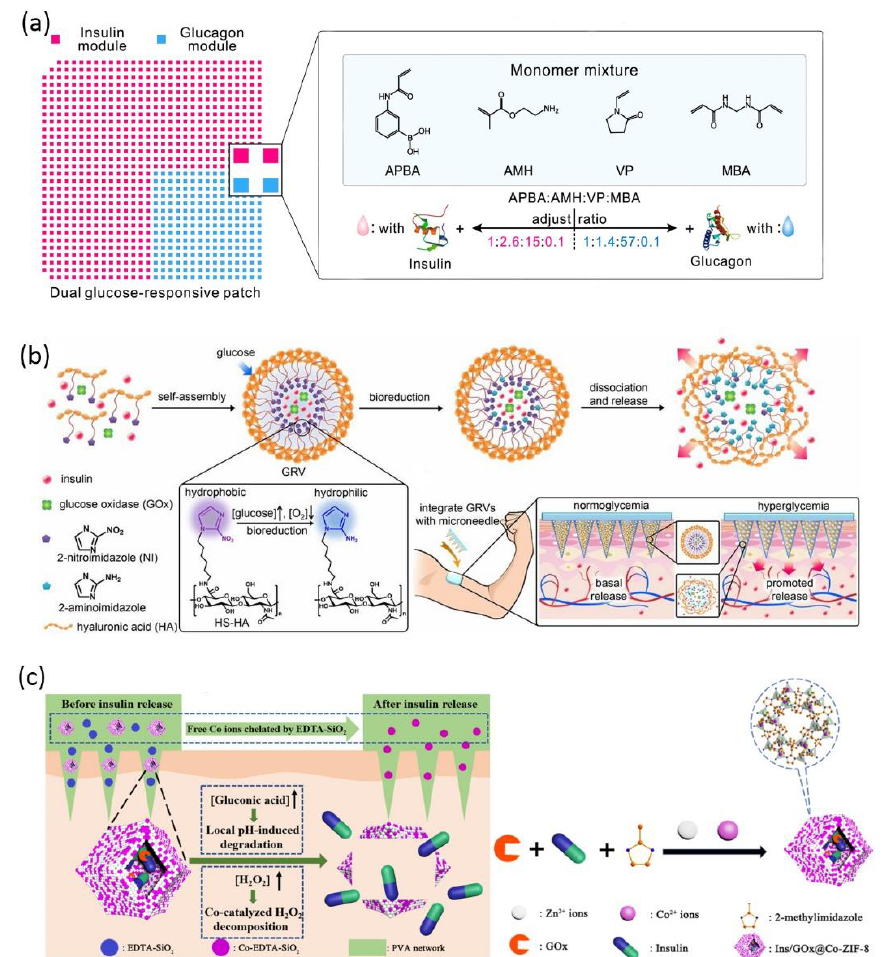
Figure 4. Schematic of glucose-responsive insulin delivery microneedles: ( a ) A dual-module mi- croneedle patch to separately encapsulate insulin and glucagon. The two modules comprise different ratios of key monomers, synergistically responding to both hyperglycemic and hypoglycemic states (reproduced with permission from Wang et al., Proceedings of the National Academy of Sciences of the United States of America; published by National Academy of Sciences, 2020) [174]; ( b ) fast-responsive MN patch loaded with hypoxia-sensitive hyaluronic acid (HS-HA) vesicles containing insulin and GOx. In localized hypoxic environment, the hydrophobic 2-nitroimidazole groups of HS-HA are reduced to hydrophilic 2-aminoimdazole, leading to the dissociation of vesicles and subsequent release of insulin (reproduced with permission from Yu et al., Proceedings of the National Academy of Sciences of the United States of America; published by National Academy of Sciences, 2015) [179]; ( c ) the insulin and glucose oxidase are encapsulated in metal–organic framework and further loaded into the microneedle matrix. The low pH induced by glucose oxidation leads to framework degradation and insulin release. The preloaded Co 2+ catalyzes the decomposition of the byproduct H 2 O 2 . The excessive Co 2+ is chelated by EDTA-SiO 2 nanoparticles in the microneedle matrix (reproduced with permission from Yang et al., ACS Applied Materials & Interfaces; published by ACS, 2020) [176].